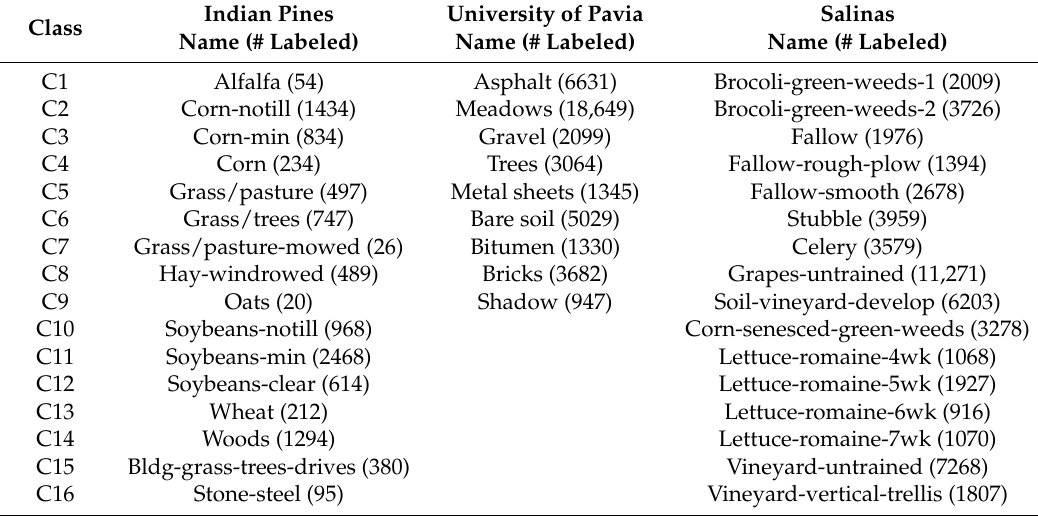
Table 2. Information classes and the number of labeled samples for four considered image